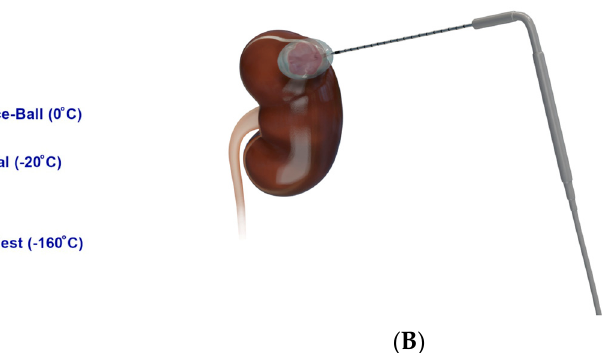
Figure 4. Schematic presentation of cryoablation . ( A ) Design of a cryoprobe, whereby a cryogen circulates to rapidly cool the cryoprobe to − 160 °C, resulting in an ice ball around the cryoprobe of varying temperatures, of which − 20 °C is lethal [26]. Figure adapted from Nelson et al. [26]; ( B ) Representative example of cryoablation used to target a kidney tumor.